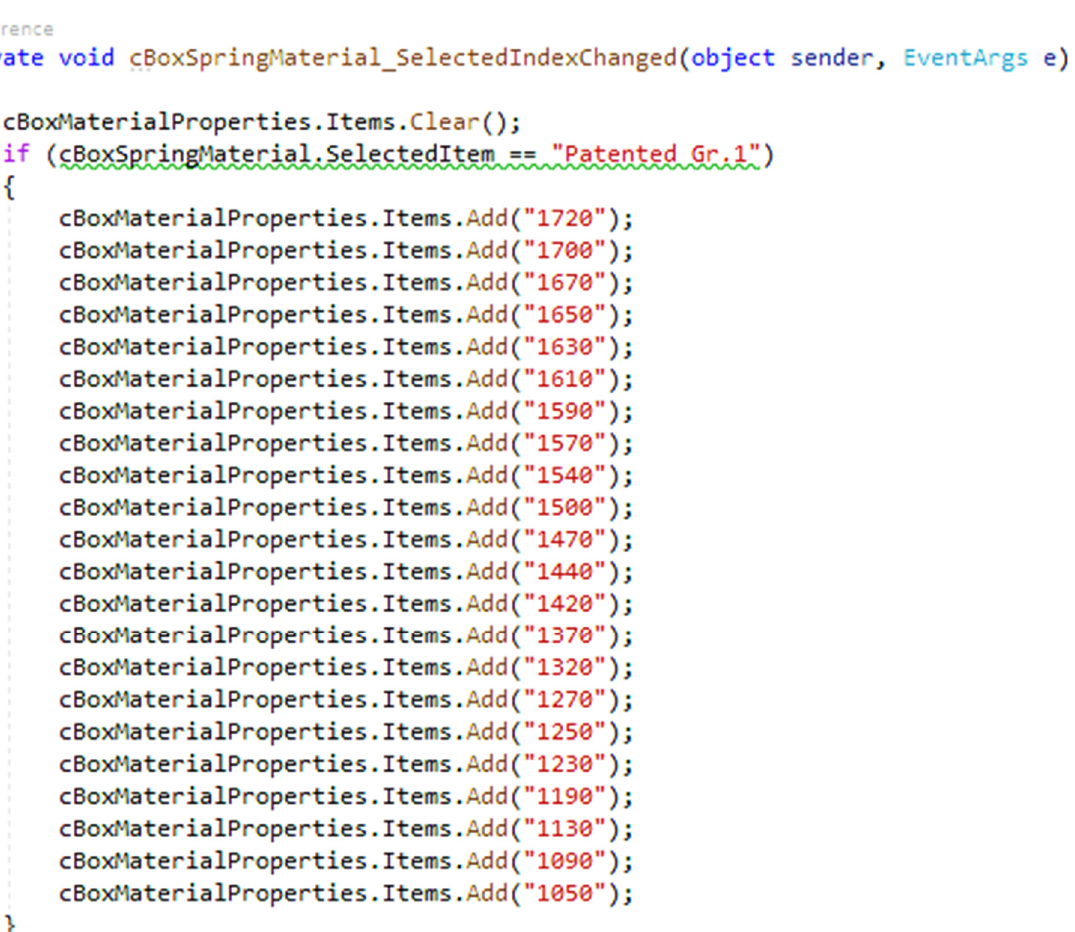
Figure 4. C# code snippet used for the database programming (figure shows the ultimate tensile strengths for patented grade 1 spring wire which are available in user interface via simple if function implementation).